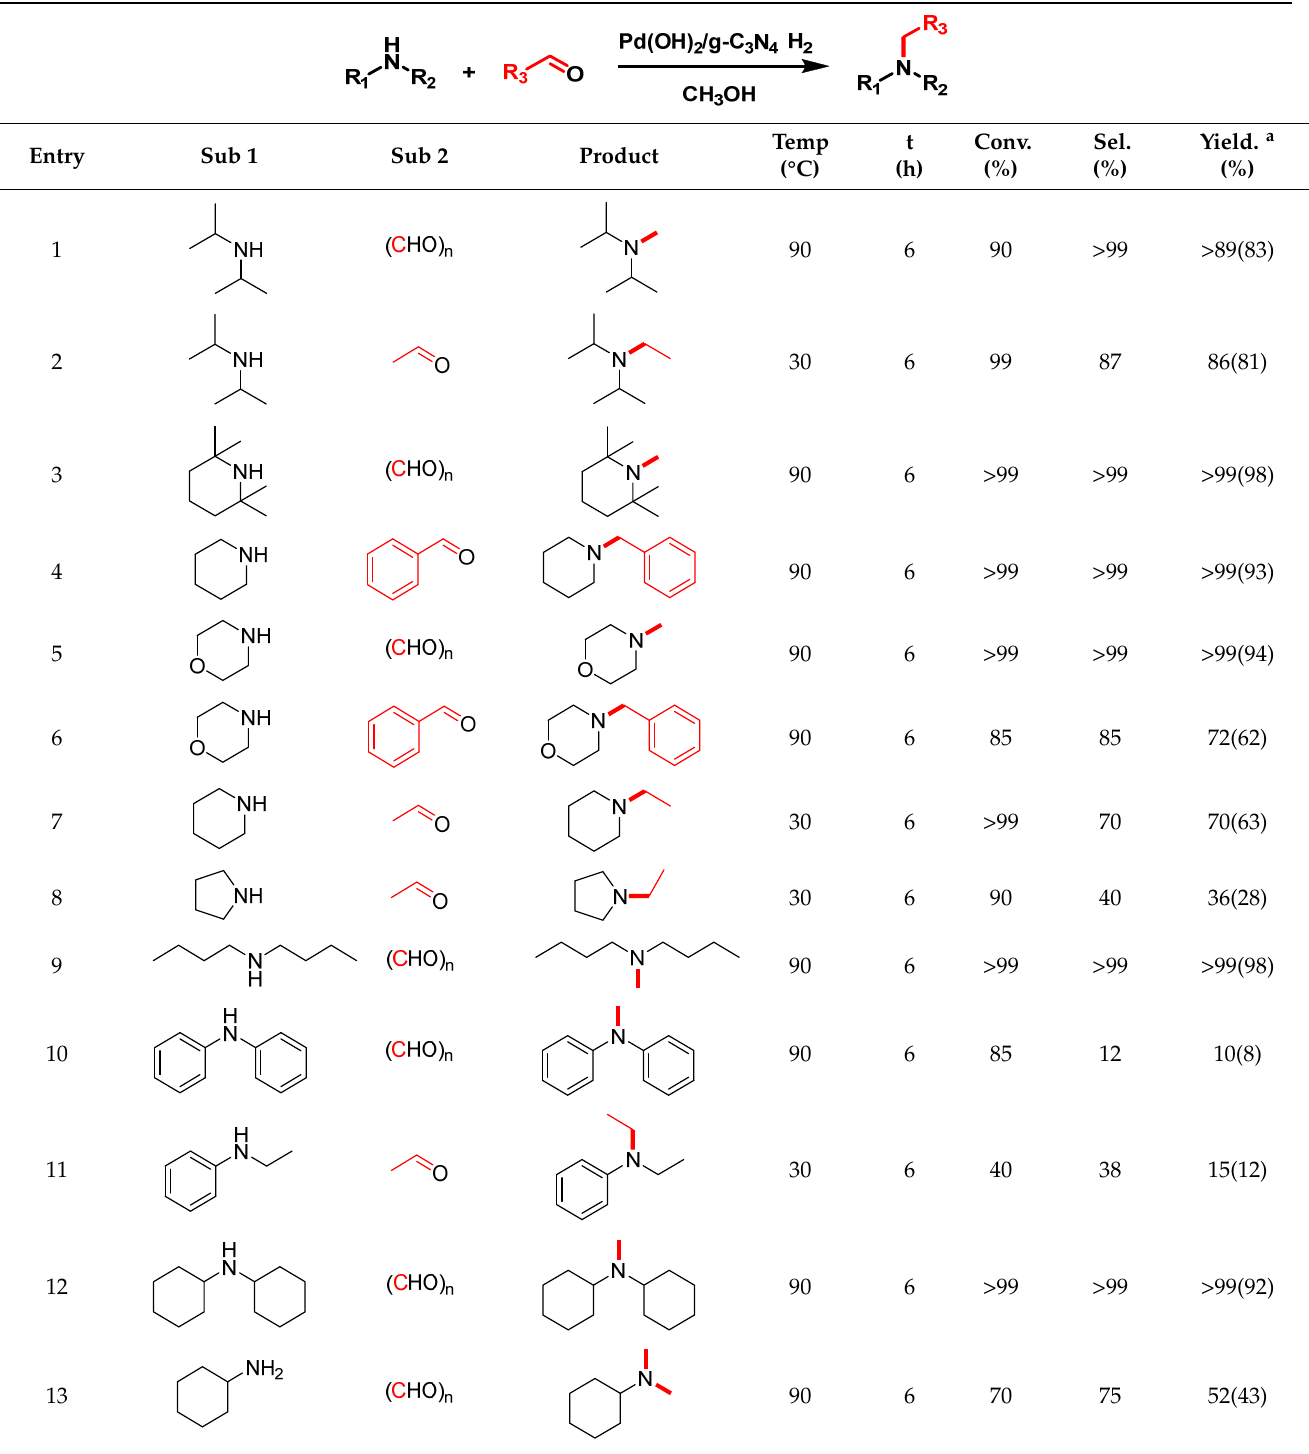
Table 2. Reductive Amination Towards Aldehydes and Amines catalyzed by Pd(OH) 2 /g-C 3 N 4.